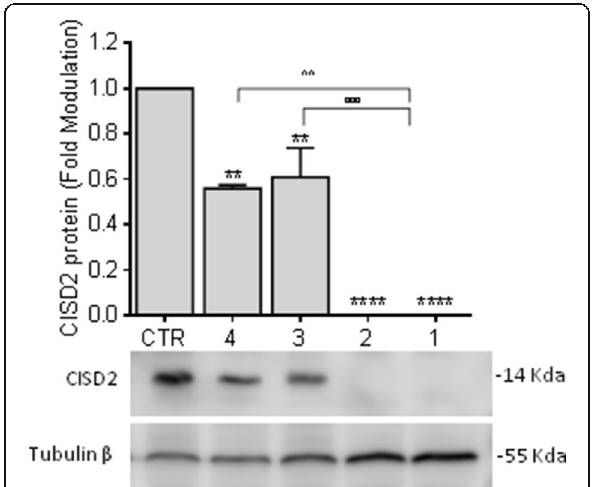
Fig. 3 Analysis of CISD2 protein expression in PBMCs. The CISD2 protein levels were analysed by Western blot analysis using polyclonal antibody raised against the CISD2 C-terminus encompassing the CDGSH iron sulfur domain. The CISD2 protein decreased approximately 50% in heterozygous samples compared with healthy PBMCs, and the signal was undetectable in the patient samples. β tubulin was used as loading control. The panels show representative images of three independent experiments. The histogram shows values normalized relative to a housekeeping protein and expressed as fold modulation compared with the healthy control. The error bars represent the mean ± SEM for three experiments. Ordinary one-way ANOVA, ****P <